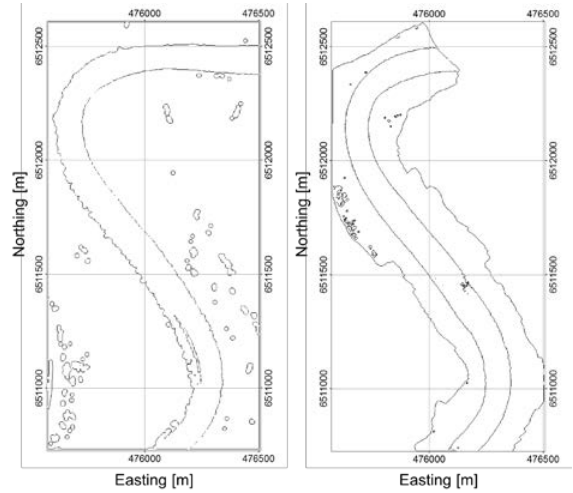
Figure 11. Output from the Median filter and Laplacian edge detector. Left: SAR image. Right: sUAS ortho-image mosaic.